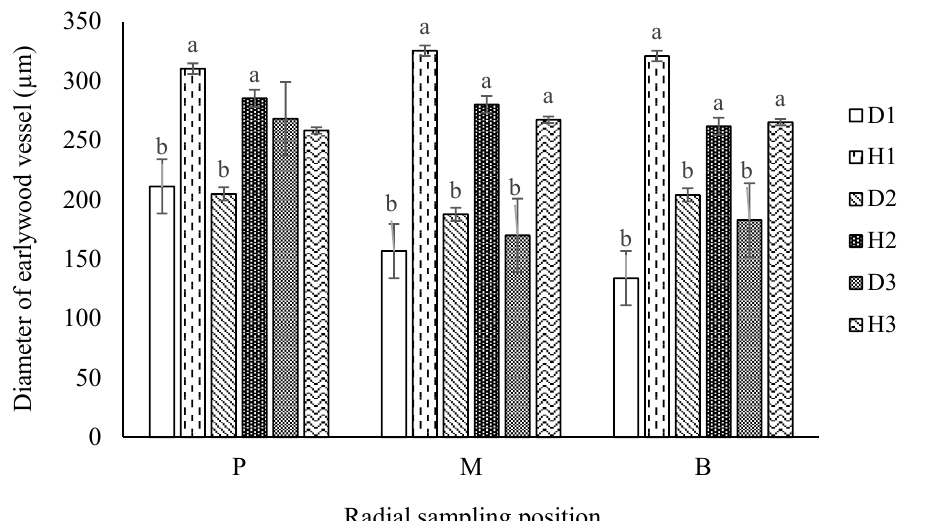
Figure 4. Mean diameter of earlywood vessels in declined and healthy trees of Quercus brantii . H: Healthy trees; D: Declined trees; 1: Area A; 2: Area B; 3: Area C; P: Near-pith; M: Middle; B: Near-bark. The bar on each column represents the SE (standard error). Columns with no letters on them indicate insignificance. Table 4. One-way ANOVA of wood-anatomical variables between healthy trees and those with decline at the three study areas.